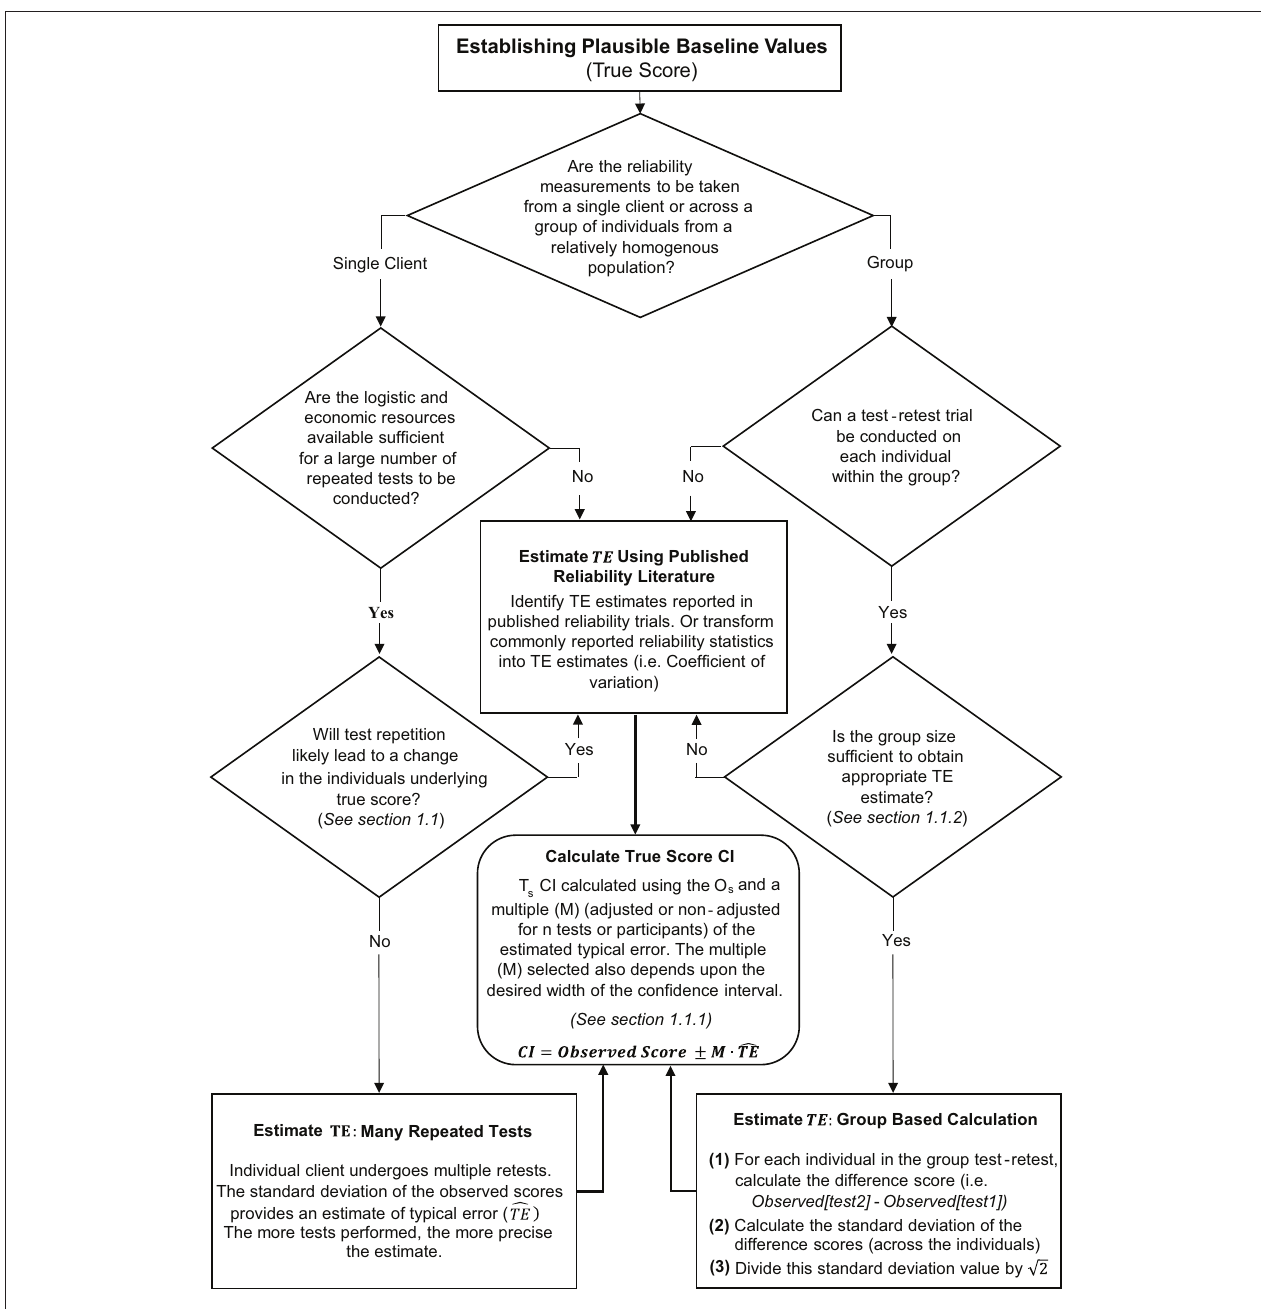
FIGURE 3 | Schematic overview of procedures to estimate typical error and calculate true score confidence